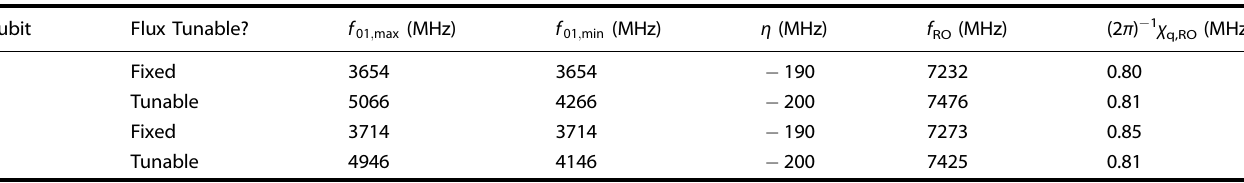
Table 4. Hamiltonian properties as designed.